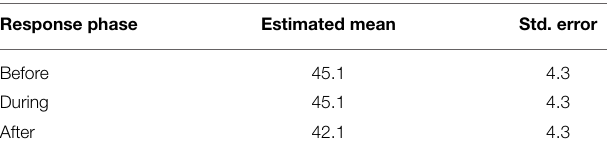
TABLE 2 | Estimated means and standard errors for “Happiness” before, during and after execution of Gesture C. Response phase Estimated mean Std. error